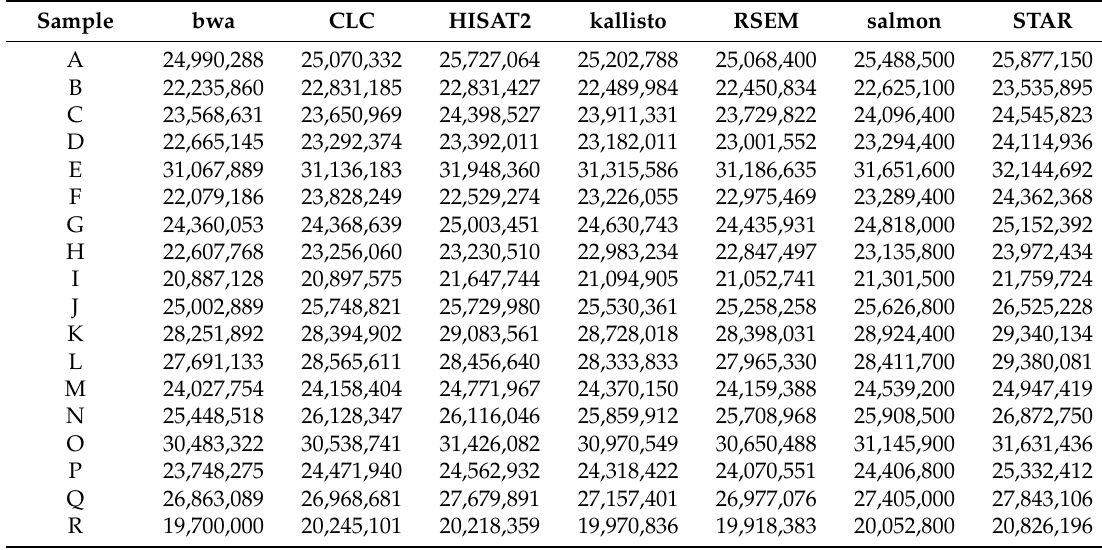
Table A2. Number of mapped reads for each mapper and